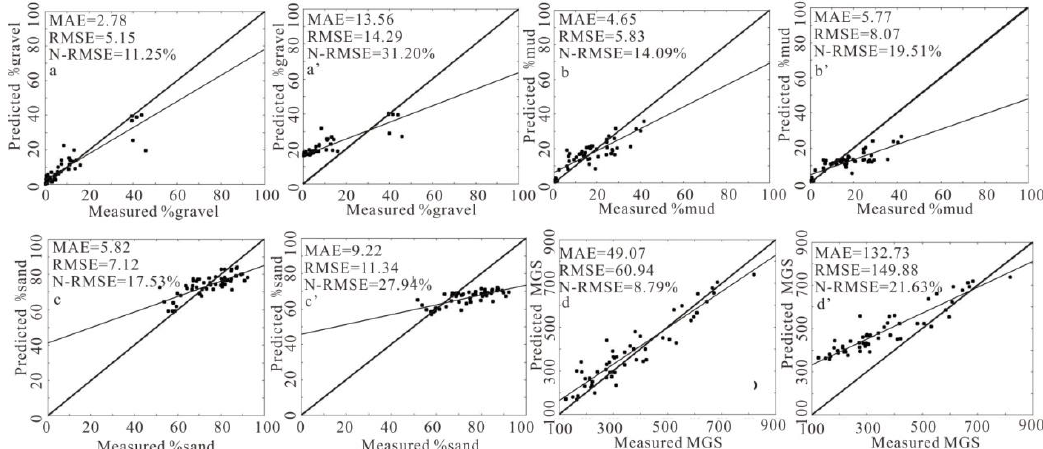
Figure 5. The correlation between measured and acoustic values of sediment properties and the statistical error evaluation. ( a – d ) indicate the result of that BM and BS were set as the explanatory variable. ( a’ – d’ ) indicate the result of that BS was set as the explanatory variable. ( a , a’ ), measured %gravel and acoustic %gravel; ( b , b’ ), measured %mud and acoustic %mud; ( c , c’ ), measured %sand and acoustic %sand; ( d , d’ ), measured MGS and acoustic MGS. MAE indicates the mean absolute error. RMSE indicates the root mean square error. N-RMSE indicates the normalized root mean square error.